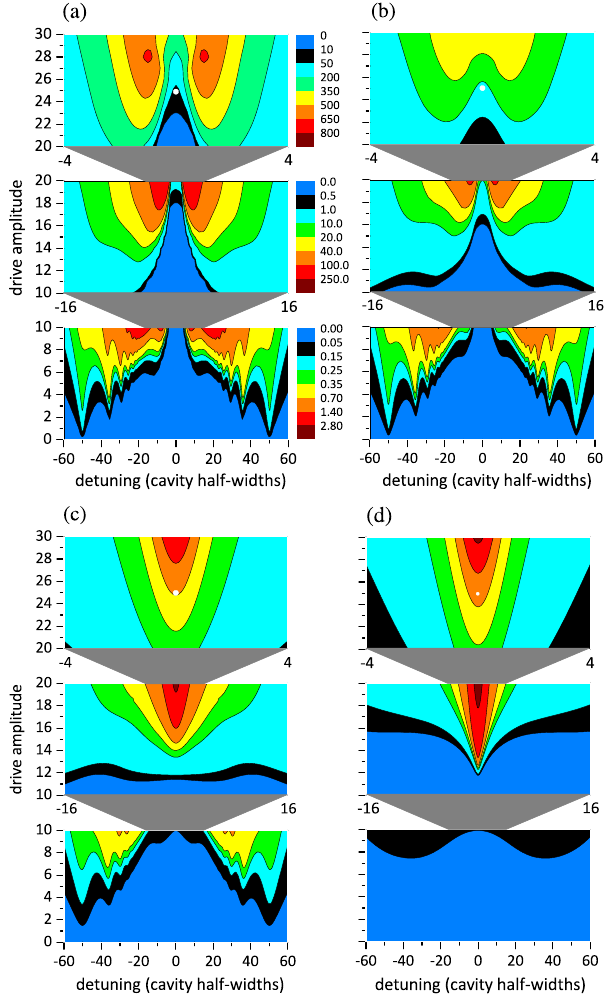
FIG. 7. As in Fig. 1 with spontaneous emission at the rate